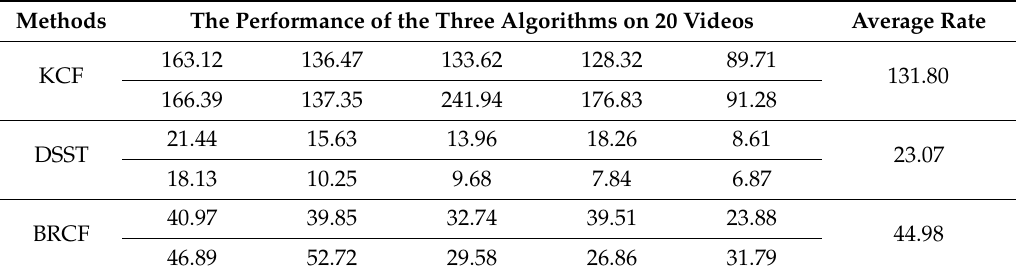
Table 2. Comparison of processing rate on our marine traffic dataset.